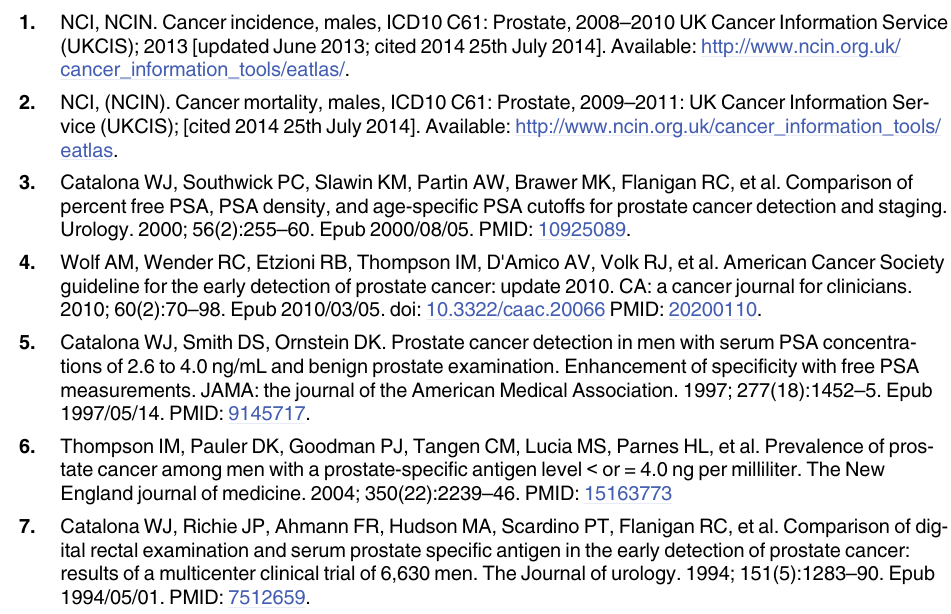
S1 Table. Summary of urological problems and co-morbidities and medication of study participants. S2 Table. Volatile organic compounds in urine library, tentatively identified by relative ion abundances detected (mass